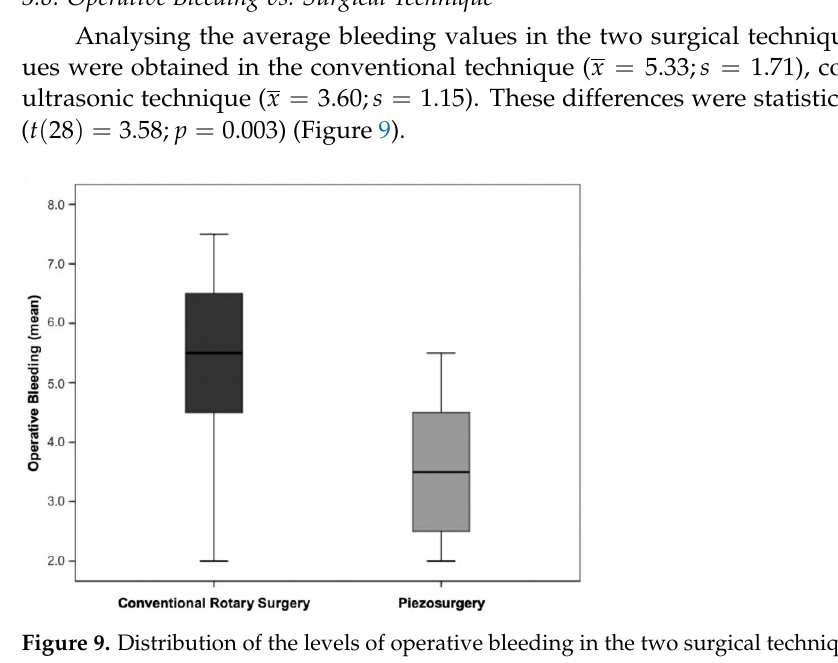
Figure 9. Distribution of the levels of operative bleeding in the two surgical techniques ( p = 0.003 for the comparison between the two techniques). the comparison between the two